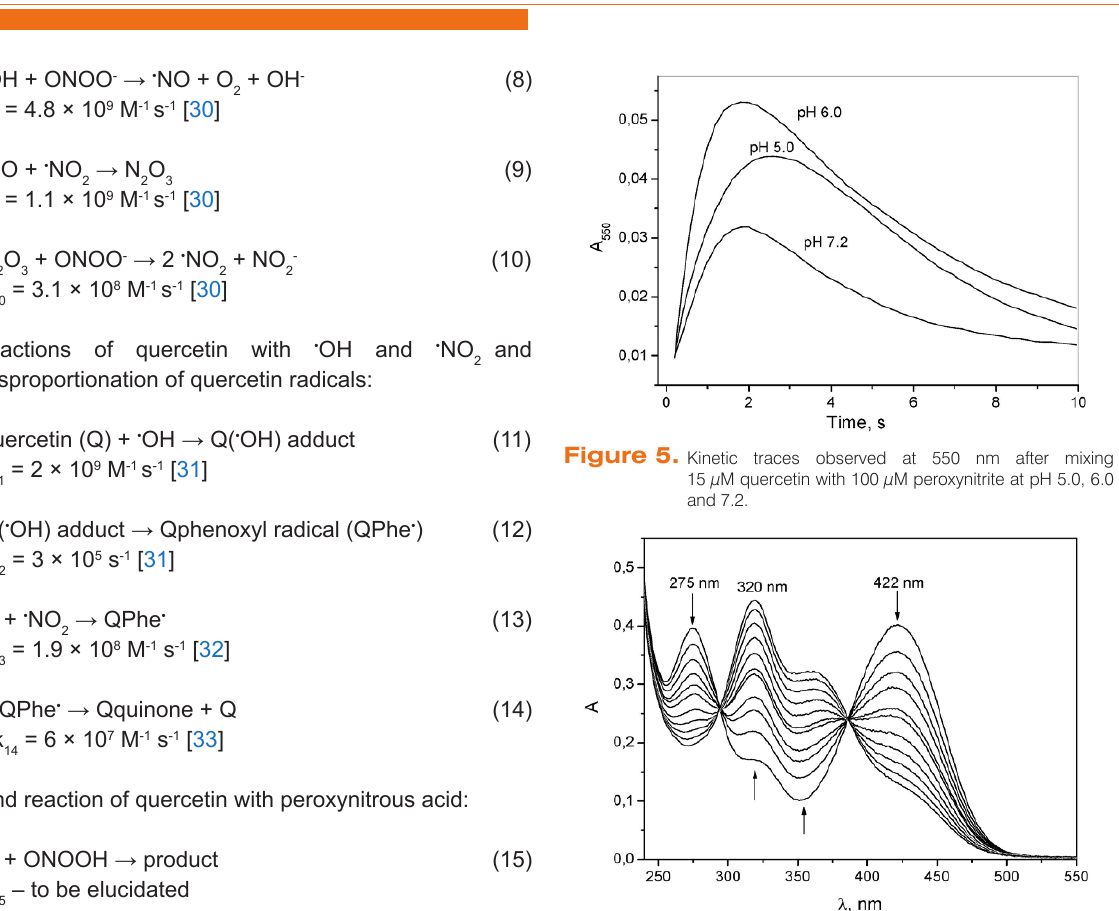
Figure 6. Absorption spectra of 20 µM quercetin at pH 11.0 taken every 2 min after alkalization of quercetin solution.